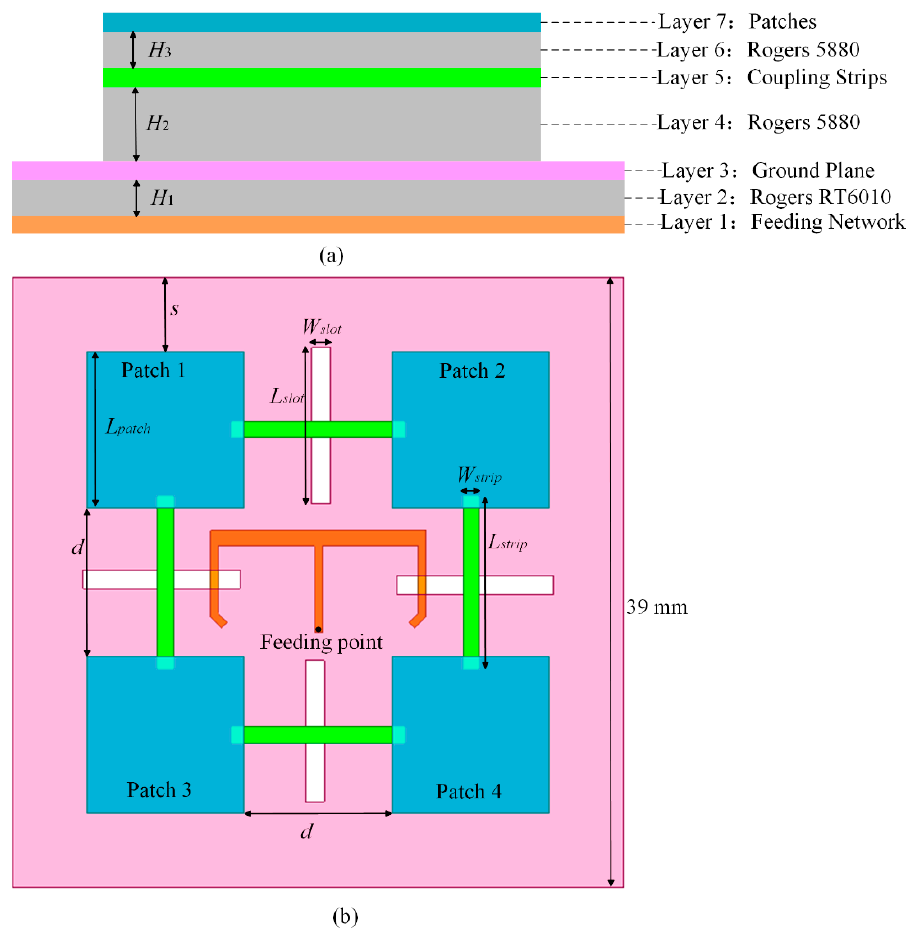
Figure 1. Configuration of the proposed antenna with one port. ( a ) Side view of the proposed antenna with one port. ( b ) Top view of the proposed antenna with one port.